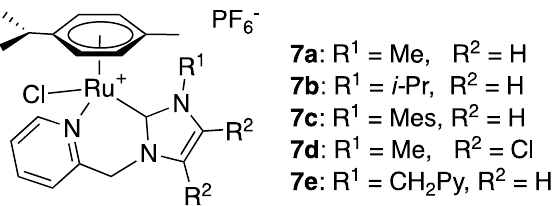
Figure 1. ( η 6 - p -cymene)Ru(II) complexes 7a – e bearing picolyl-NHC ligands.